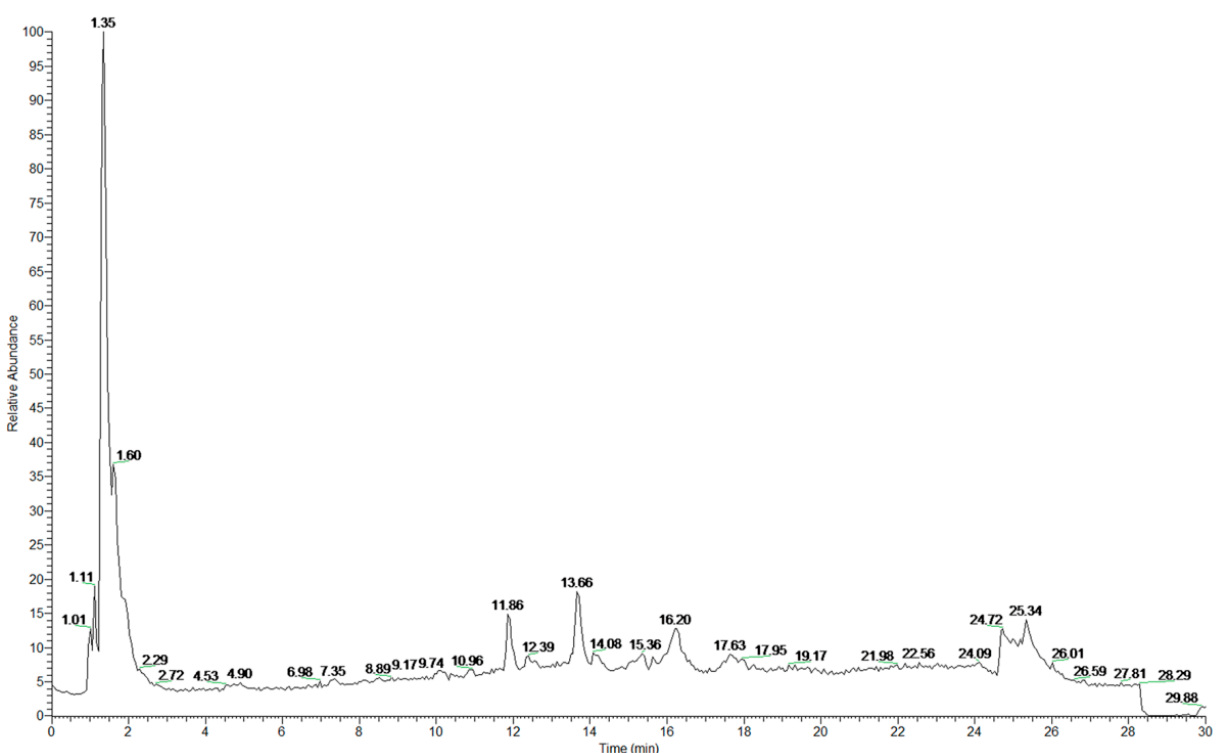
Figure 4. UPLC chromatographic separation of phenolic compounds from HBWG.